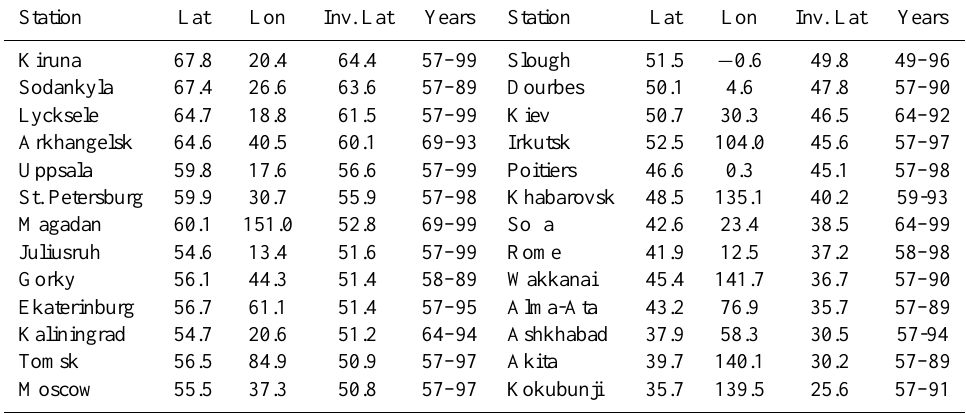
Table 1. List of stations and periods of observations available, geodetic coordinates and invariant latitudes of the stations are given.